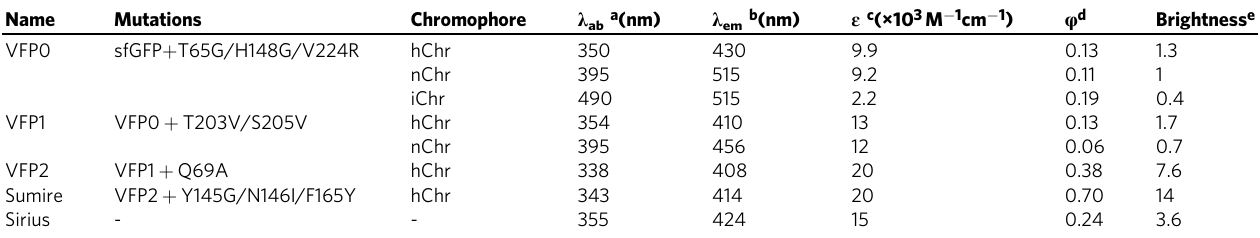
Table 1 Fluorescence propaties.